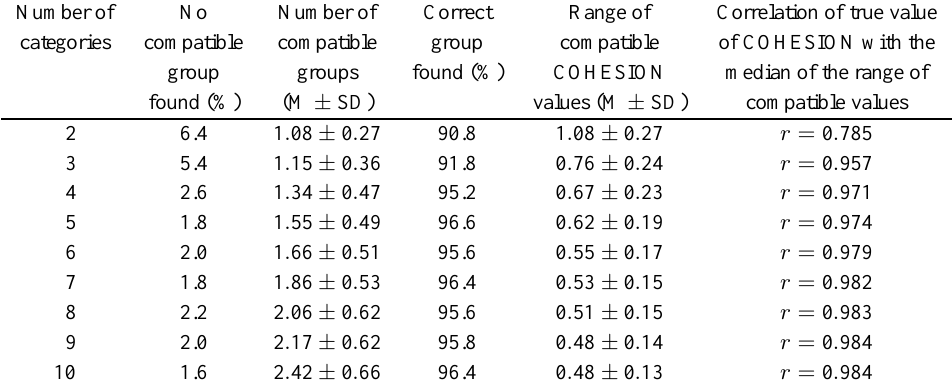
Pattern interpretation in simulated tumour patterns using cellular automata. Variation of a single parameter (COHESION). Influence of the number of categories. The learning set comprised 200 simulations in each group. Compatibility of groups was determined by taking into account all pattern measurement features (M (cid:6) SD = mean (cid:6) standard